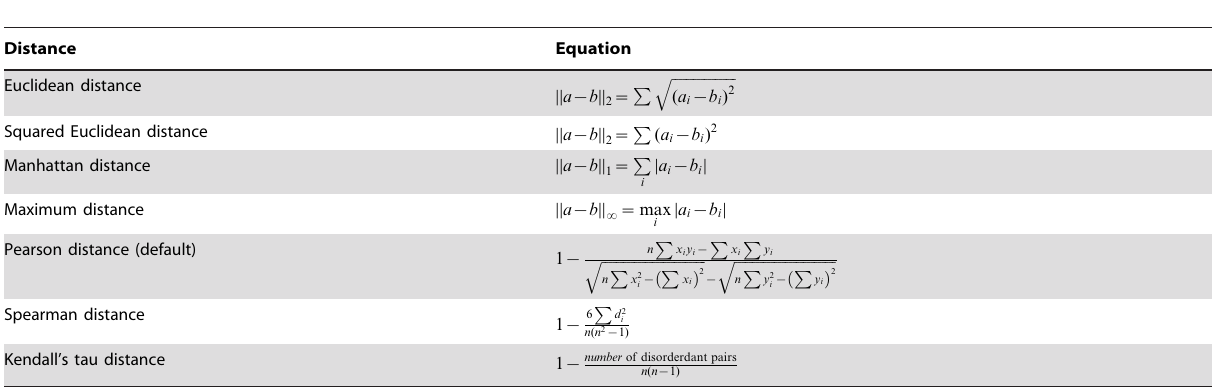
Table 4. Seven distances for the